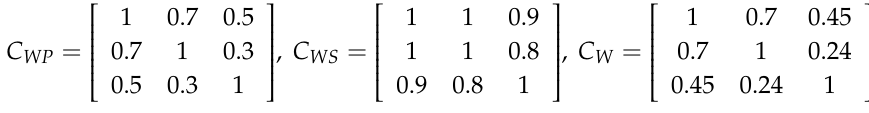
W SV Figure 9. Distributed power and electric vehicle related access methods. Figure 10 illustrates the PDFs of PLF results at four nodes, Node 11, 21, 26, and 30. Three algorithms are compared, including 10,000 iteration of MCS using PLF, ILHS-CM PLF with correlation, and ILHS-CM PLF without correlation. Table 6 shows the deviation estimation indicators of the voltage PDF at each node according to Equation (34).